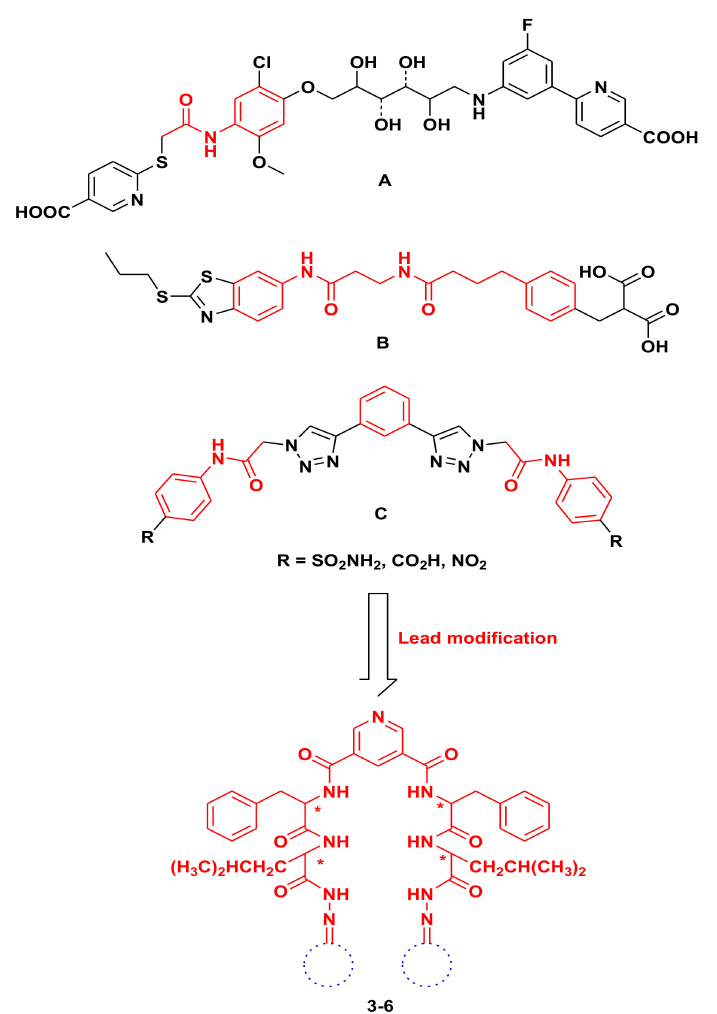
Figure 1. Design of new target derivatives 3 – 6 via lead modification of known candidates A – C having promising cytotoxic and LDHA inhibitory